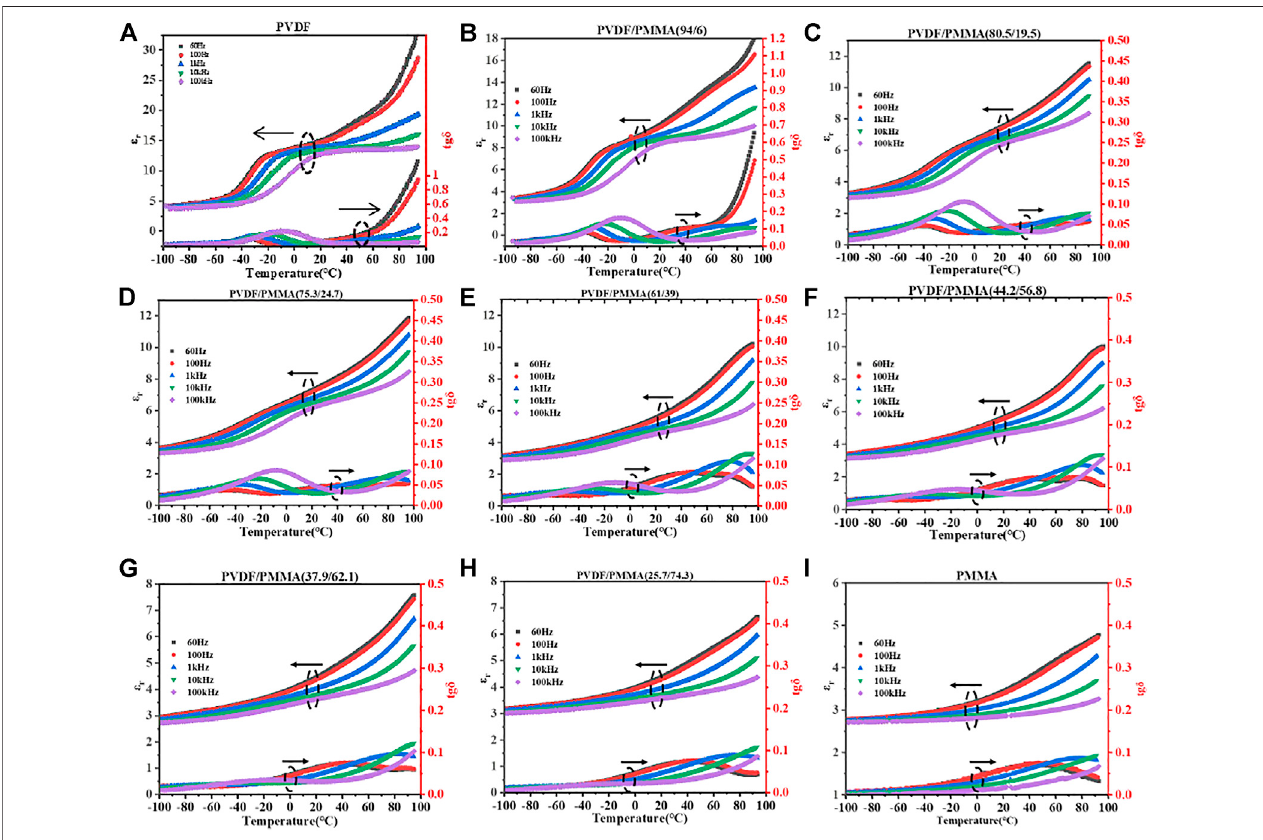
FIGURE6| TemperaturedependenceofdielectricpermittivityforPVDF/PMMAwithPMMAcontentsof (A) 0%, (B) 6%, (C) 19.5%, (D) 24.7%, (E) 39%, (F) 56.8%, (G) 62.1%, (H) 74.3%, and (I) 100%.